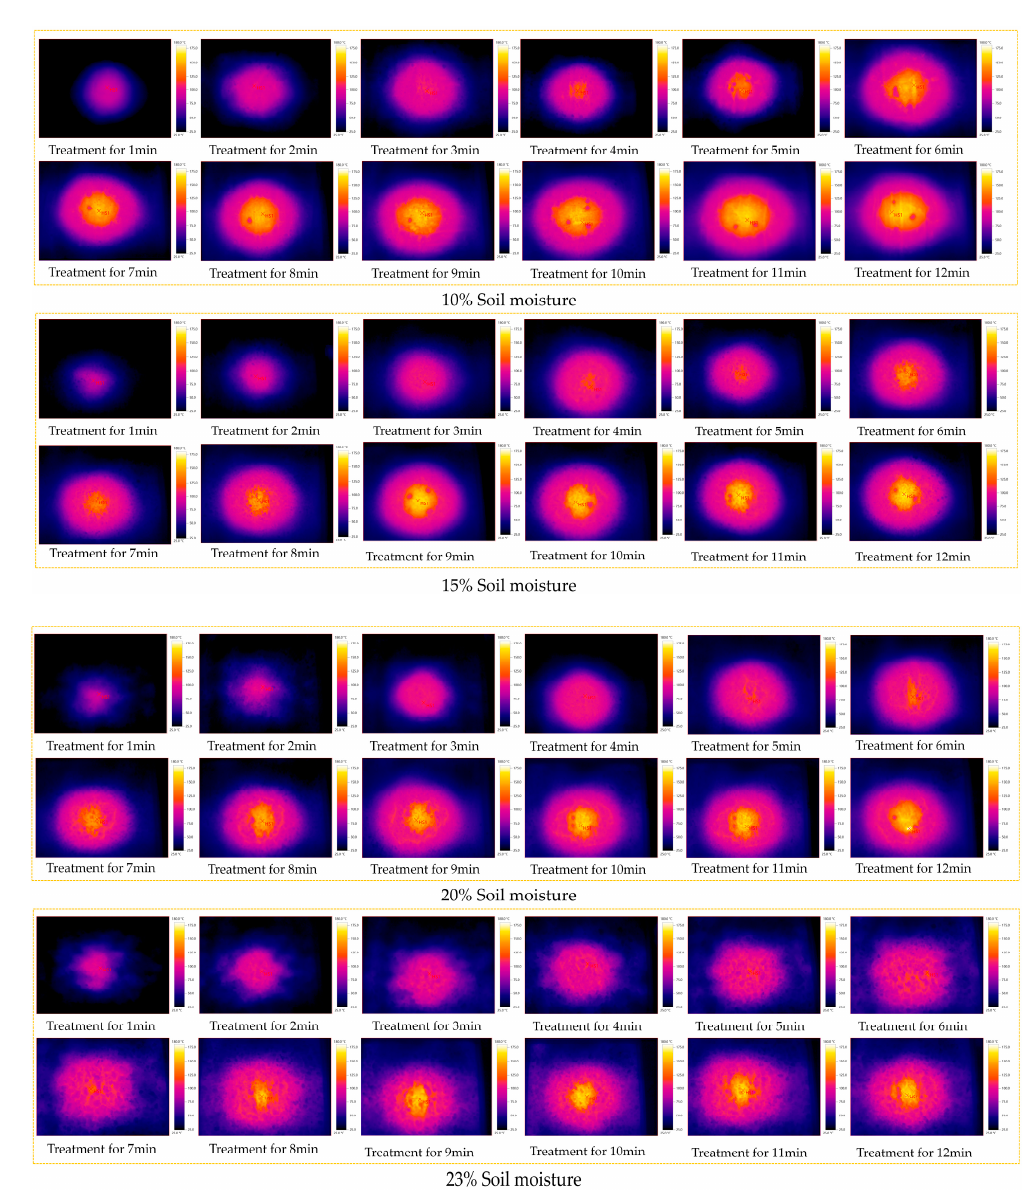
Figure 11. Thermal image of loess surface irradiated by microwaves. The surface temperature difference between North China loess and Northeast black soil after microwave irradiation is mainly caused by the different composition ratios of